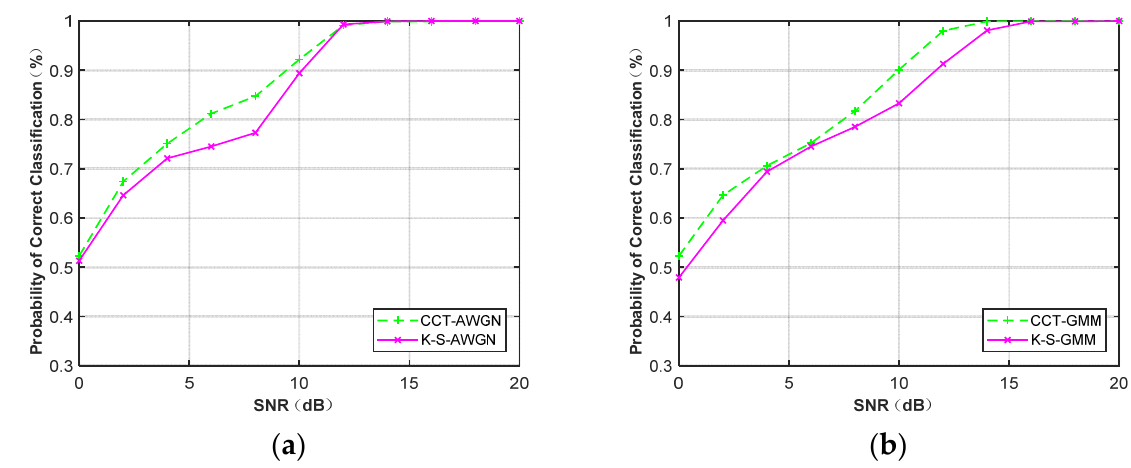
Figure 16. Performance comparison of MQAM based on the feature CDF (N = 512). ( a ) AWGN. ( b ) Non-Gaussian channel.